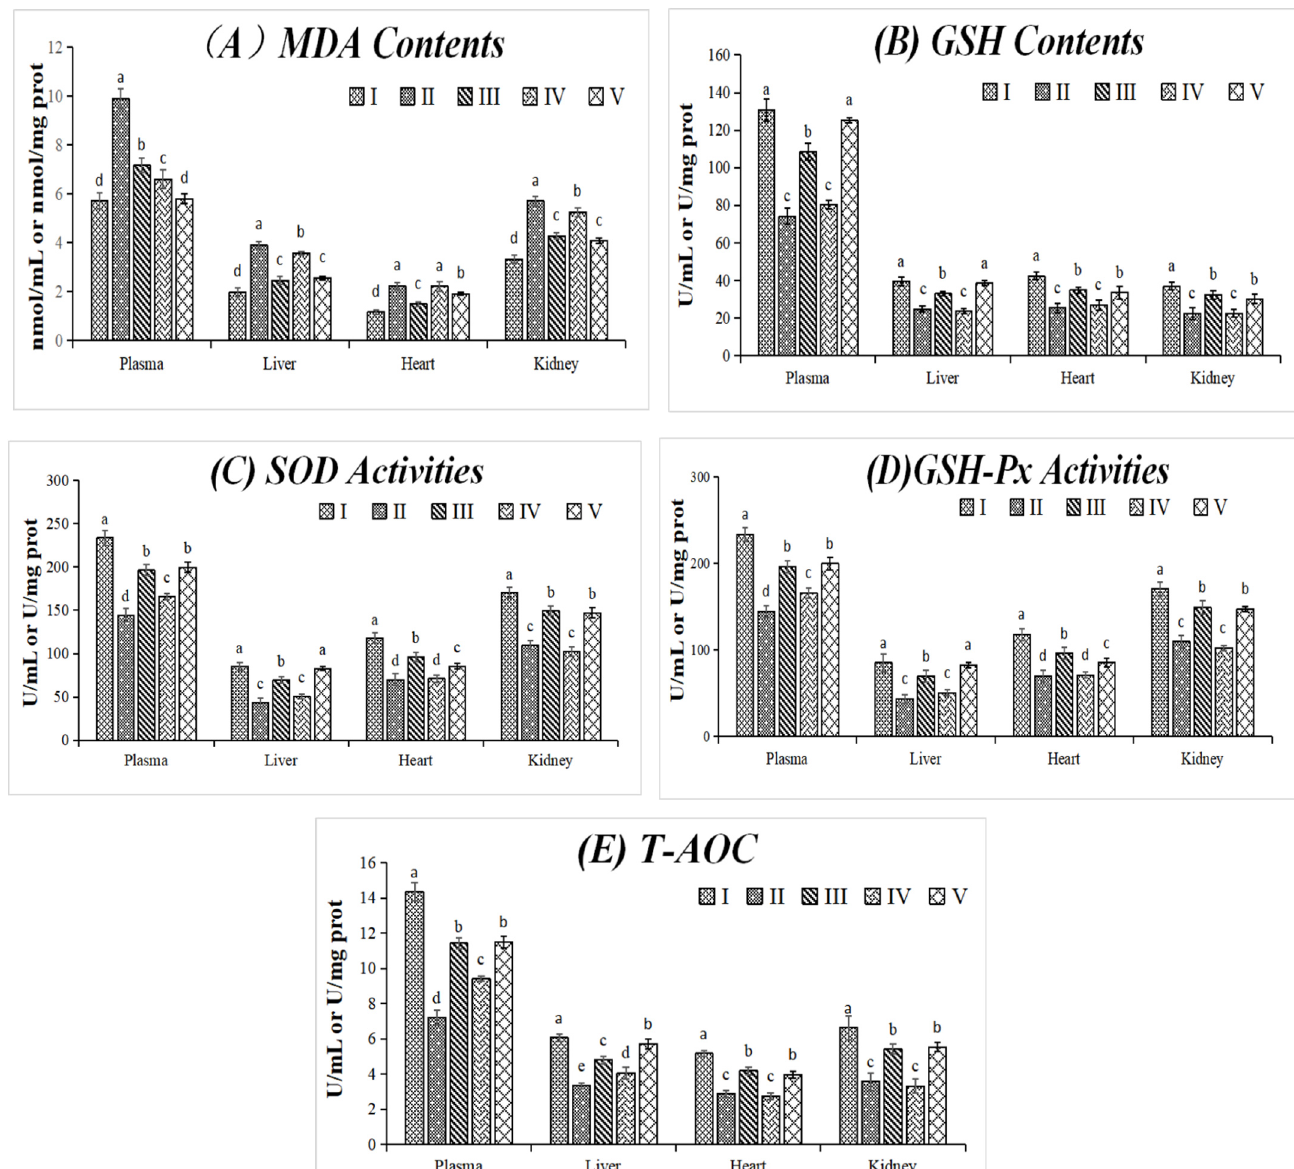
Figure 3. The changes of ( A ) MDA contents; ( B ) GSH contents; ( C ) SOD activities; ( D ) GSH-Px activities; and ( E ) T-AOC in different groups. Data were presented as mean ± SD ( n = 8); values not sharing a common superscript letter denote significant difference ( p < 0.05). Rats were divided into 5 groups as follows: I: normal control group (saline); II: model control group (D-gal solution, 200 mg/kg BW); III: positive control group (VC solution, 200 mg/kg BW), IV: low dosage group (THR extract, 200 mg/kg BW), and V: high dosage group (THR extract, 1000 mg/kg BW). Please note that the data of the I, II, and III groups were the same as we used in our previous paper ( Journal of Functional Foods 2017, 30, 179–193), experiments for which were carried out simultaneously with the current paper.